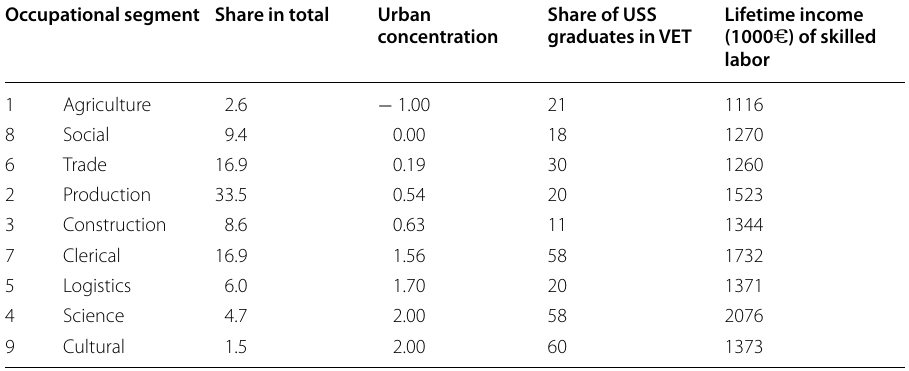
For the calculation of "urban concentration", the category "rather urban" has been ascribed the value 2, rather peri-urban the value 1, rather all-over the value 0, and rather rural the value -1 (compare Table 1). Then the weighted mean has been calculated across a segment’s main